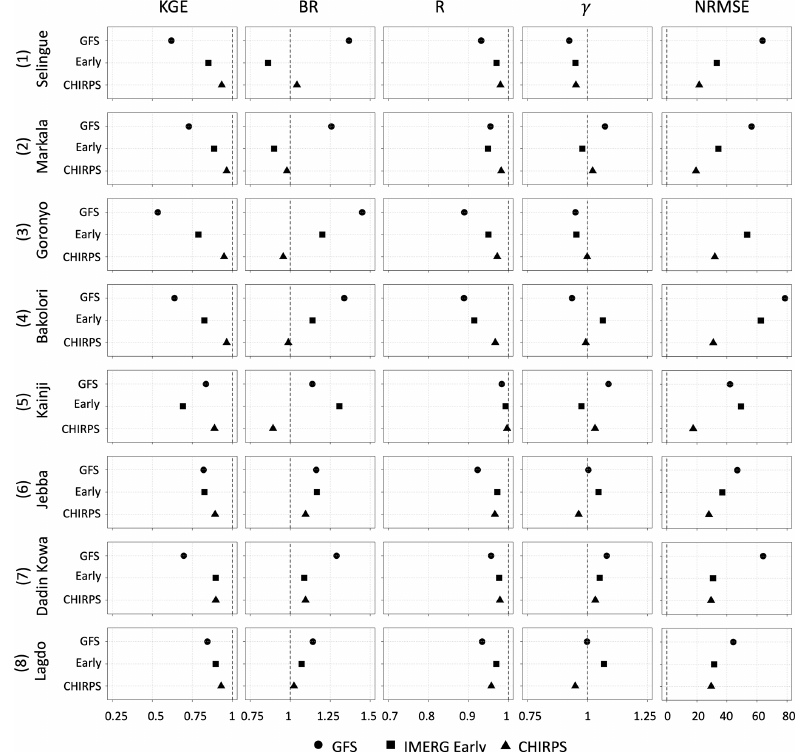
Figure 11. Summary of the performance statistics (Kling–Gupta efficiency, KGE, bias ratio, BR, correlation, R , variability ratio, γ , and root mean square error normalized (NRMSE) by reference rainfall (percent) for the 15d accumulated GFS forecast and other satellite products.